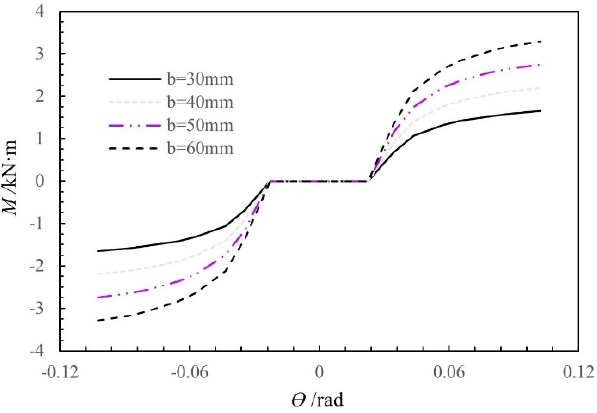
Figure 19. Moment-rotation curves of the SMTJ/WP at different widths of the tenon.